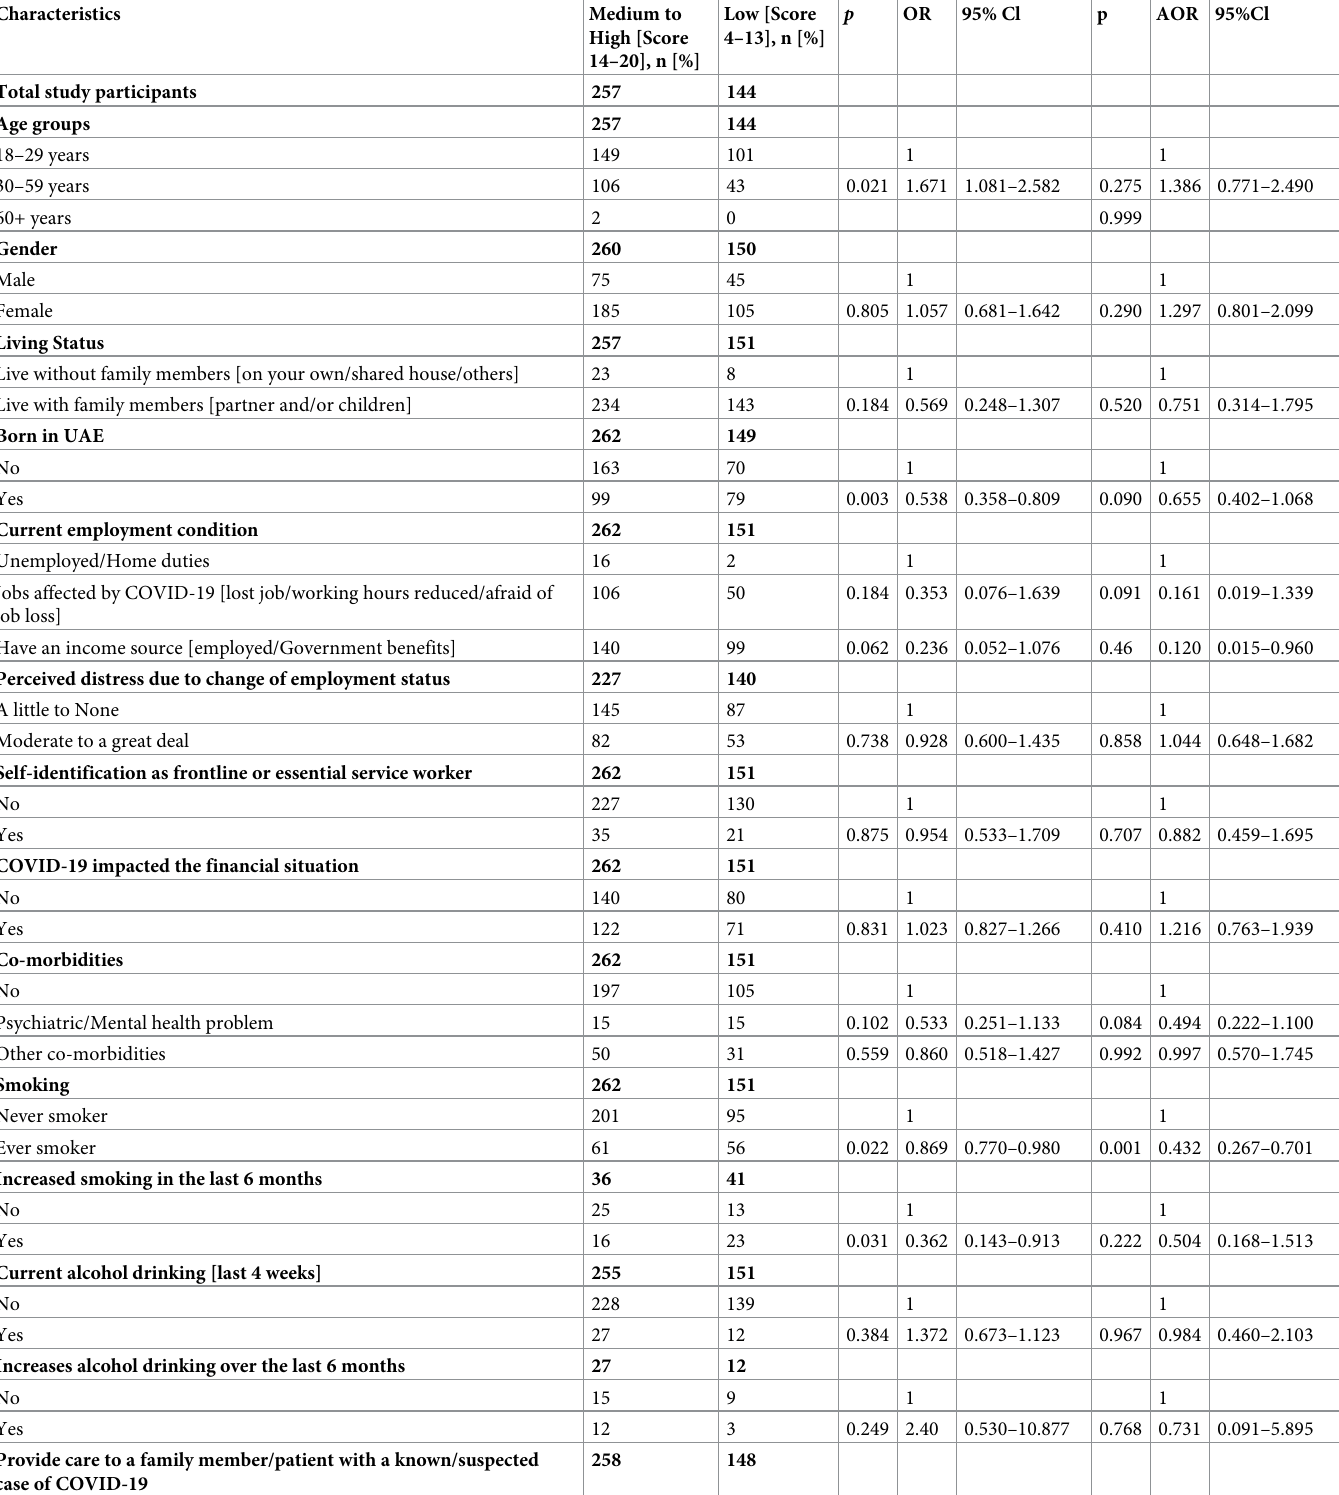
Table 4. Factors associated with medium to high resilience coping among the study participants [based on BRCS score] in UAE [November-2020].